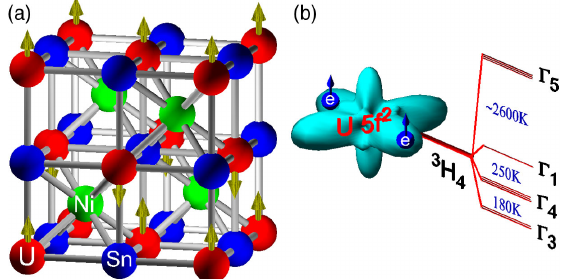
FIG. 1. (a) Crystal structure of UNiSn showing antiferromag- netic type-I ordering [32]. (b) Effect of the cubic crystal field splitting on the 3 H 4 ground state multiplet of the U f 2 two- electron state with its lowest nonmagnetic Γ 3 doublet as found experimentally